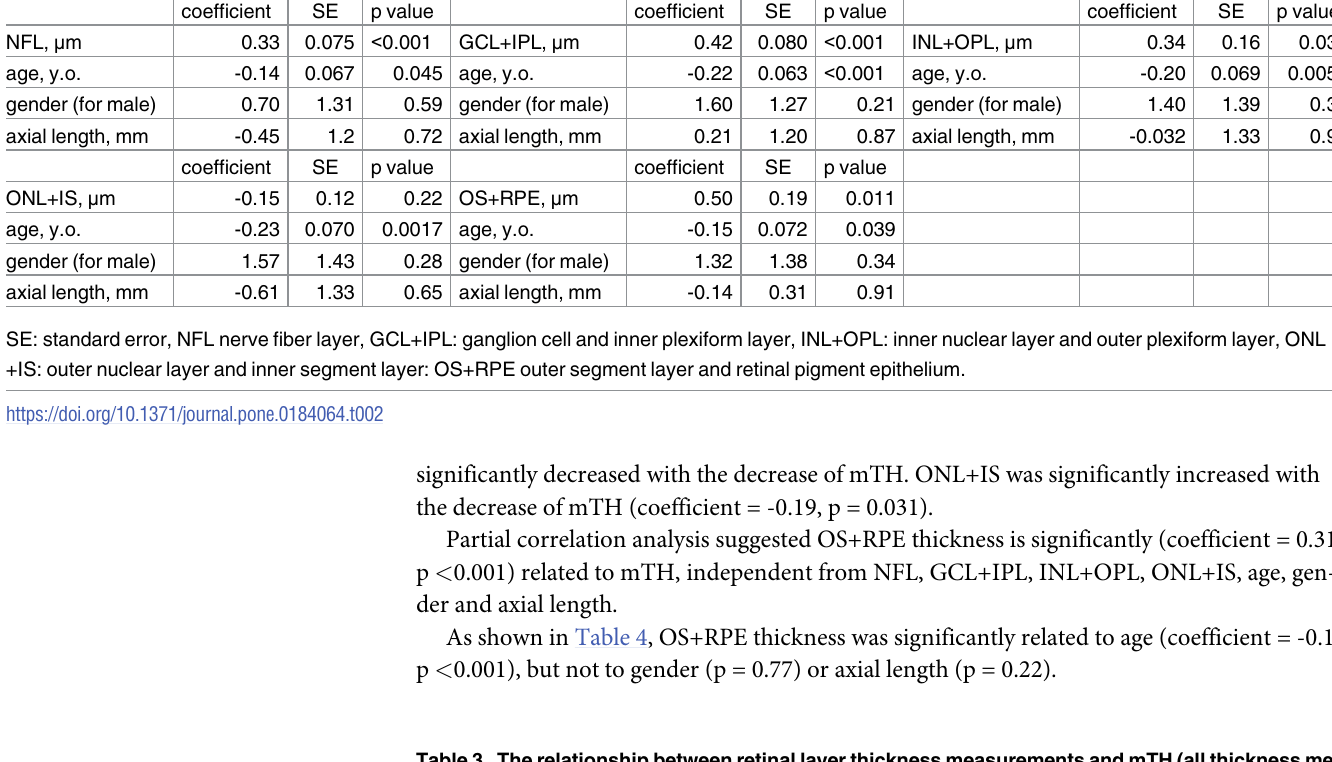
Table 3. The relationship between retinal layer thickness measurements and mTH (all thickness mea- surements were analyzed in the samelinear model). coefficient